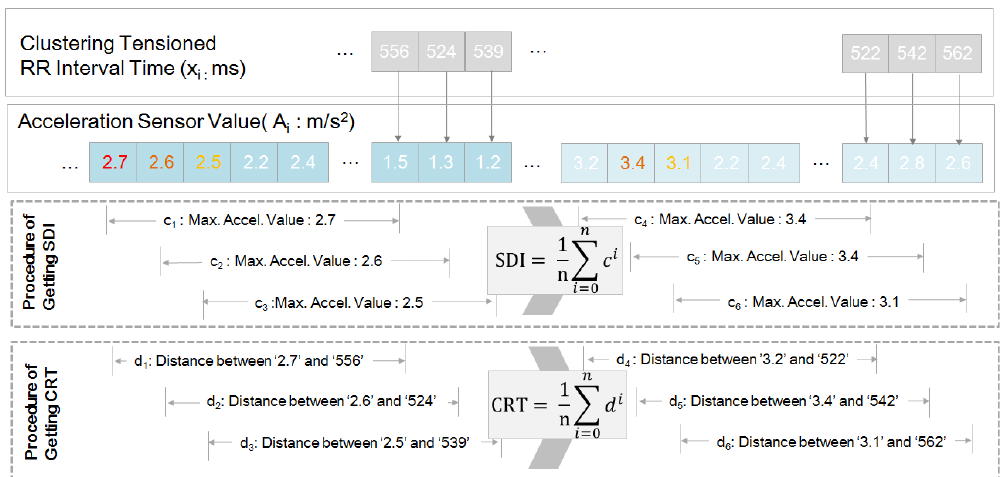
Figure 6. Procedure for obtaining the SDI and CRT. As shown here, the SDI is originated from the acceleration value and the CRT is the averaged distance between maximum the acceleration value within the MTW and each clustering heart palpitations RR interval